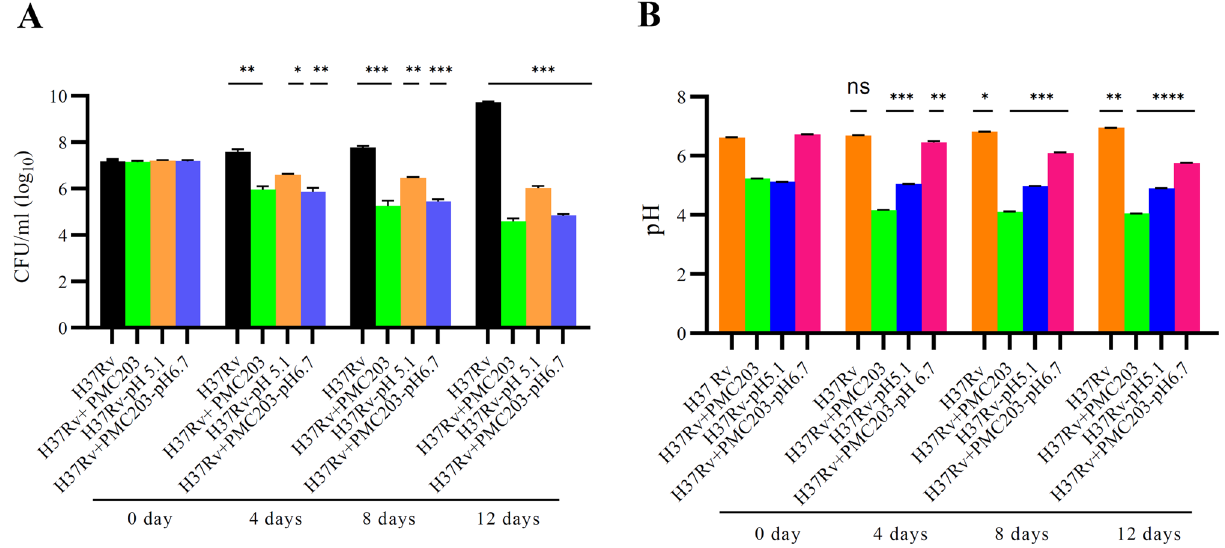
Figure 6. The activity of PMC 203 against M. tb H37Rv in Co-culture condition. Mycobacterial cells in different conditions were grown in vitro in the presence of PMC203 for 12 days. Viable bacilli were enumerated based on